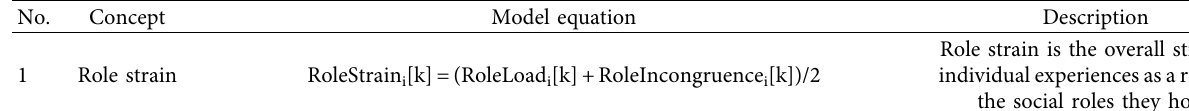
Table 1: Equations in the human-built